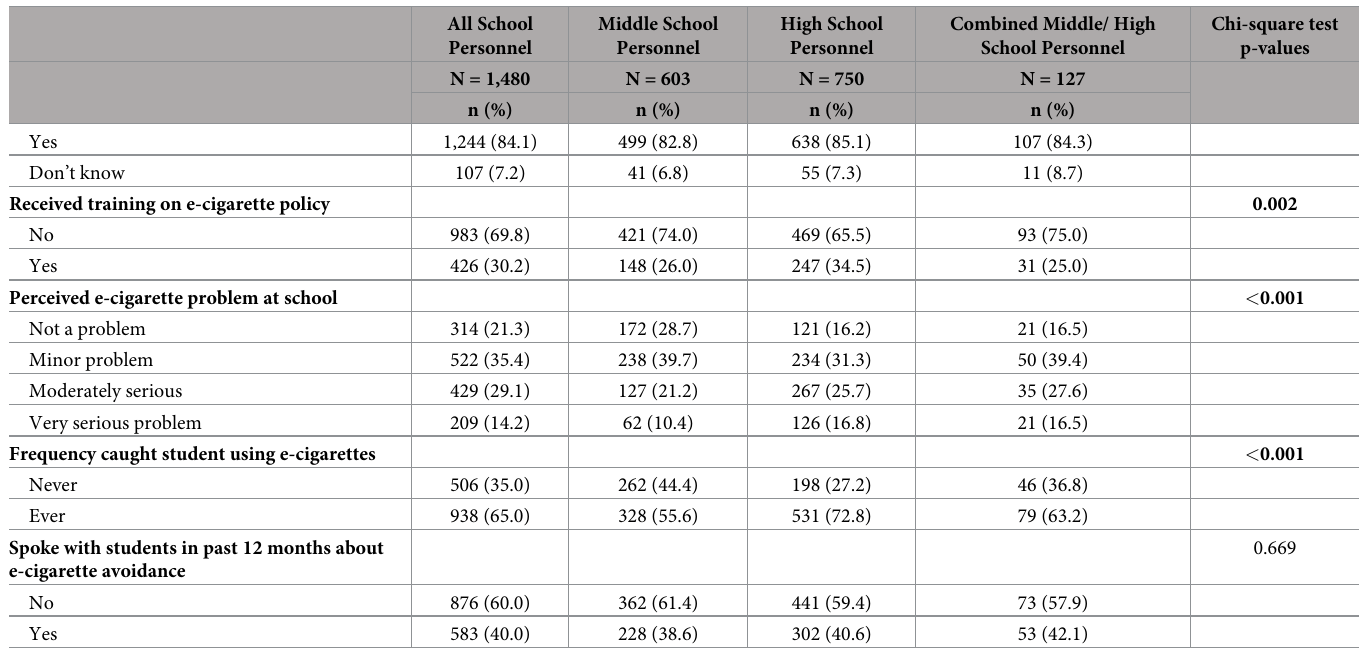
Model results for school personnel intervening on student e-cigarette use are presented in Table 3. These results include odds of: 1) communicating with students about e-cigarette avoidance and 2) perceiving that students had been caught using e-cigarettes on school prop- erty. Odds of reporting communication with students were higher if respondents reported being a current JUUL user, regardless of current use of other e-cigarettes (OR = 3.13, CI = 1.72, 5.72), compared to non-e-cigarette users. Odds of reporting communication with students about e-cigarette avoidance also increased if respondents reported that their school had an e-cigarette policy (OR = 2.39, CI = 1.59, 3.60), and as the perceived severity of student e-cigarette use increased (Very serious problem: OR = 21.40, CI = 12.62, 36.27). Respondents had higher odds of reporting communication with students about e-cigarette avoidance if they reported working in a middle school versus a high school (OR = 1.44, CI = 1.09, 1.91) or if they indicated they were a school administrator versus a teacher (OR = 2.02, CI = 1.44, 2.83). Contrastingly, the perception that students were caught using e-cigarettes was lower among respondents who worked in middle schools compared with high schools (OR = 0.66, CI = 0.49, 0.89), and was not associated with respondents’ job type. School personnel had increased odds of perceiving that students had been caught using e-cigarettes on school prop- erty if they indicated that the school had an e-cigarette policy (OR = 1.40, CI = 0.97, 2.02) ver- sus not, as perceived severity of student e-cigarette use increased (Very serious problem: OR = 27.31, CI = 15.39, 48.46), and if they reported current JUUL use (OR = 5.41, CI = 2.15, 13.59) versus non-e-cigarette users. Model results for e-cigarette and JUUL recognition among school personnel who reported that their school had an e-cigarette policy are presented in Table 4. These respondents had increased odds of JUUL text and JUUL photo recognition if they had been trained on the school’s policy (OR = 1.68, CI = 1.24, 2.28; OR = 1.54, CI = 1.18, 1.99) compared to those not trained, and had generally increased odds as perceived severity of student e-cigarette